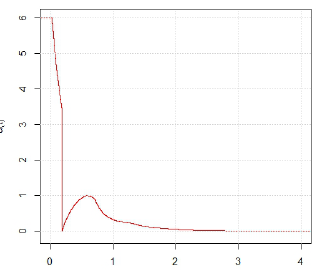
Figure 1. Trajectory of u ( t ) for DDE (22) with c = 0.